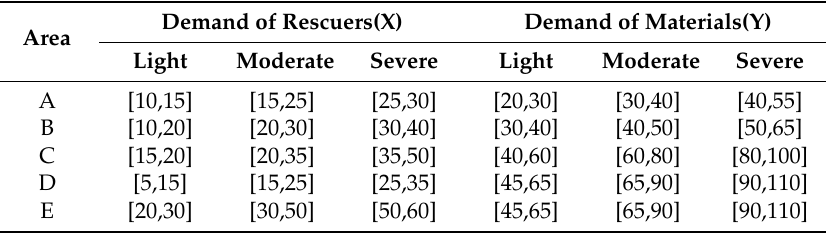
Table 3. Demand quantities of rescuers and